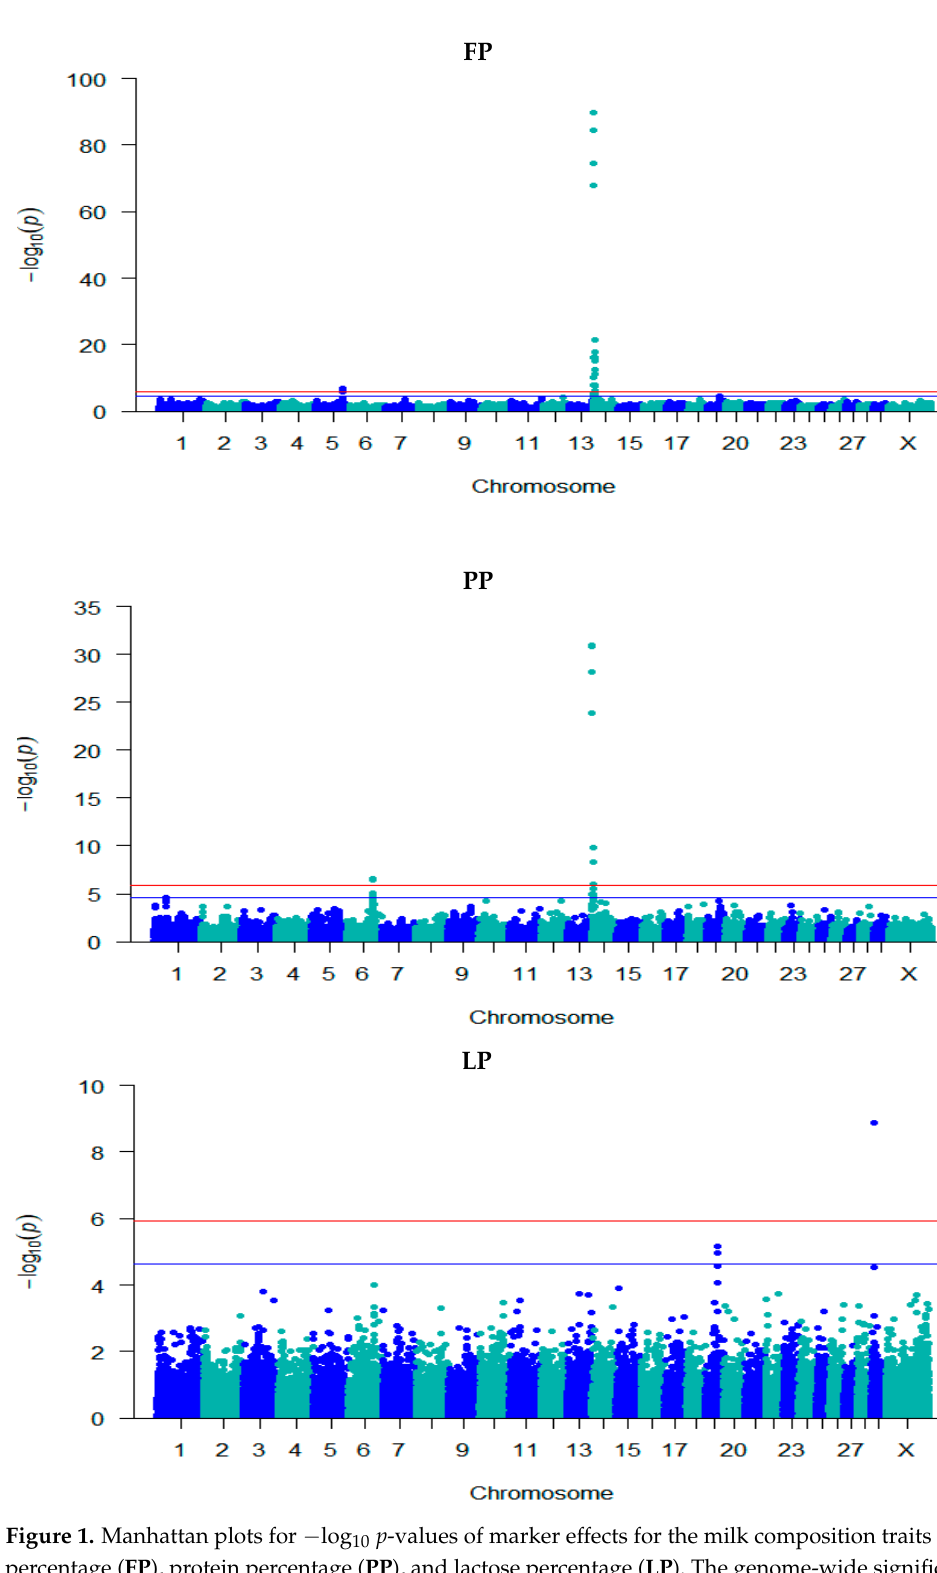
Figure 1. Manhattan plots for − log 10 p -values of marker effects for the milk composition traits of fat percentage ( FP ), protein percentage ( PP ), and lactose percentage ( LP ). The genome-wide significance threshold of Bonferroni correction is represented by the red line at − log 10 p -value = 5.93, and the suggestive significance threshold is represented by the blue line at − log 10 p -value = 4.63. Table 3. The genome-wide significant single nucleotide polymorphisms (SNPs) for the milk com- position traits of fat percentage (FP), protein percentage (PP), and lactose percentage (LP).